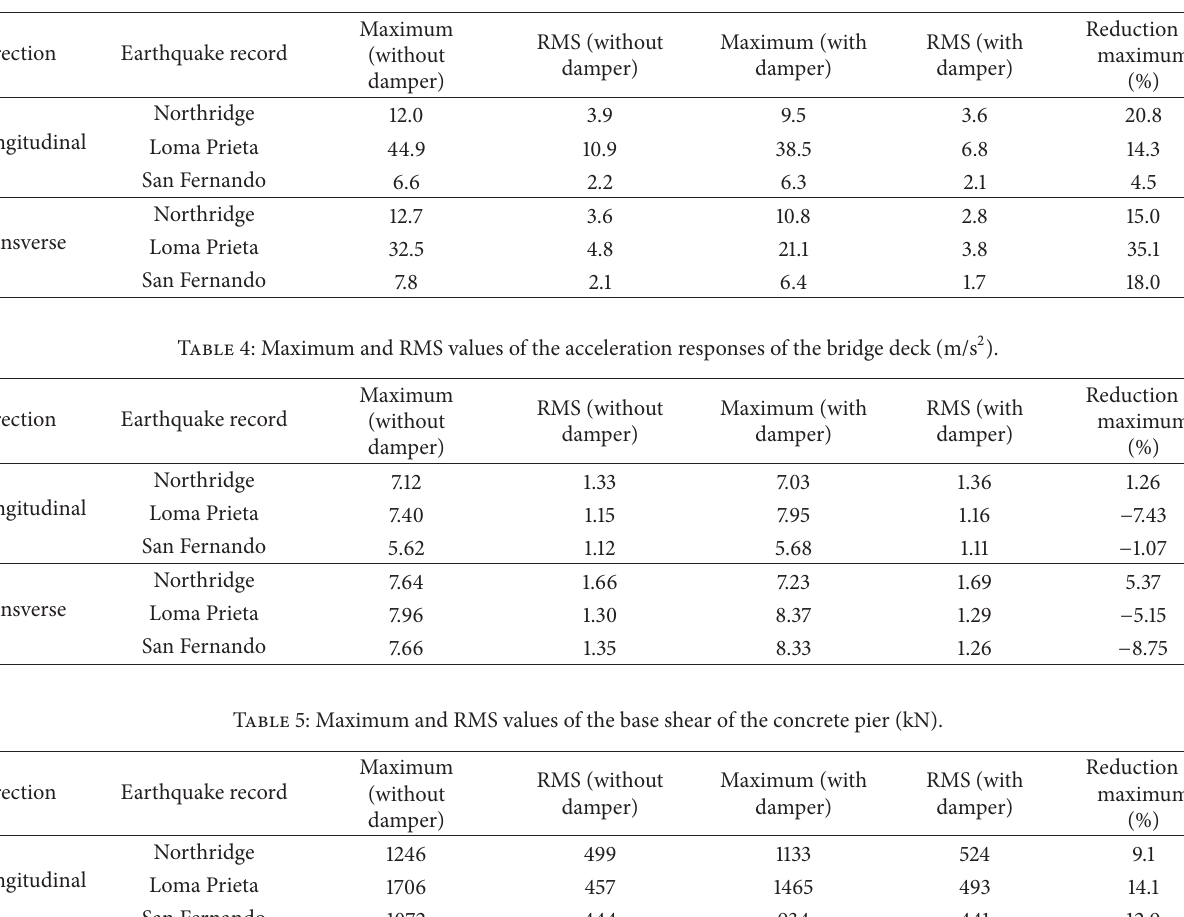
Table 3: Maximum and RMS values of the displacement responses of the bridge deck (cm). Direction